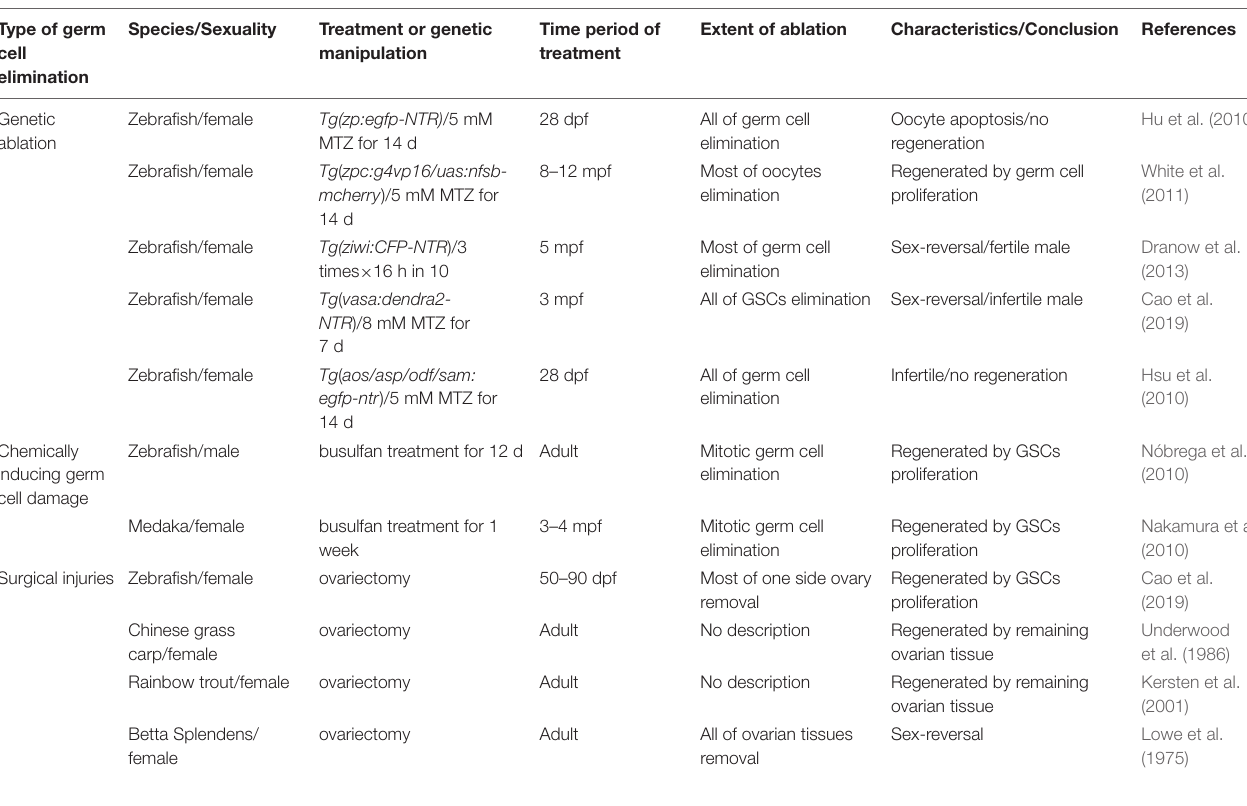
TABLE 1 | Tools for germ cell elimination in teleost